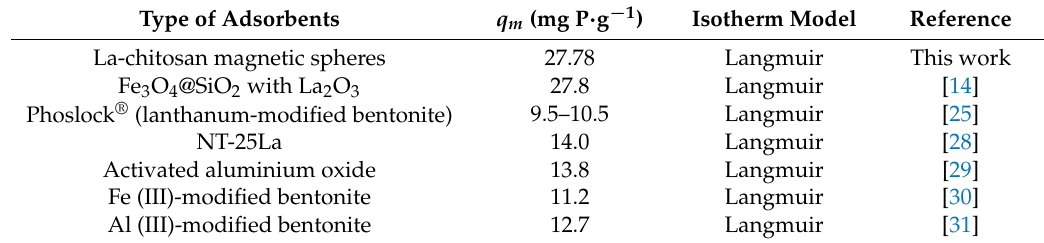
Table 4. The comparison of phosphate adsorption capacity of different adsorbents.